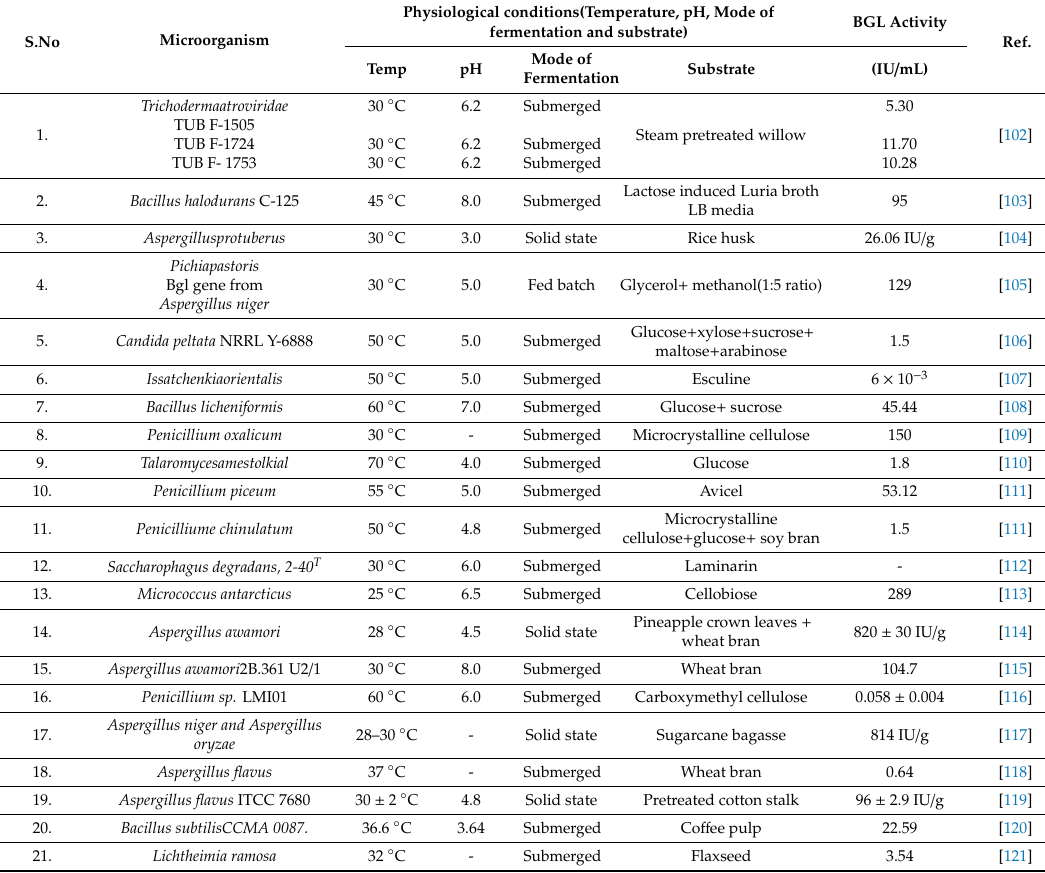
Table 1. Various microorganisms producing β -glucosidases under di ff erent physiological conditions and the activity of produced beta-glucosidase (BGL) in (IU /